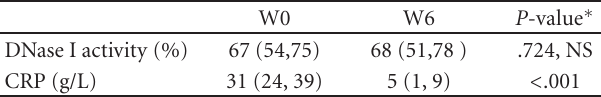
I; SLE: systemic lupus erythematosus; IBD: inflammatory bowel diseases; CTRL: healthy controls. Table 1: Dynamics of DNase I activity and serum CRP concen- tration in IBD patients during the induction phase of biological treatment ( n =